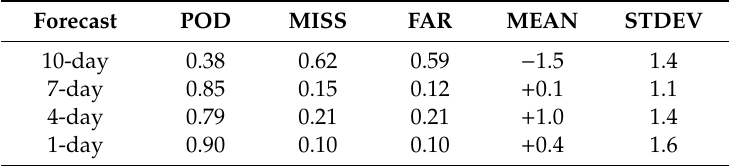
Table 2. The probability of detection (POD, 0.00–1.00), the miss rate (MISS, 0.00–1.00), false alarm rate (FAR, 0.00–1.00), mean over-forecast (positive) / under-forecast (negative) (MEAN–days), and standard deviation (STDEV–days) for the NAEFS mean ensemble IE forecasts. The latter two quantities are constructed from the data in Figure